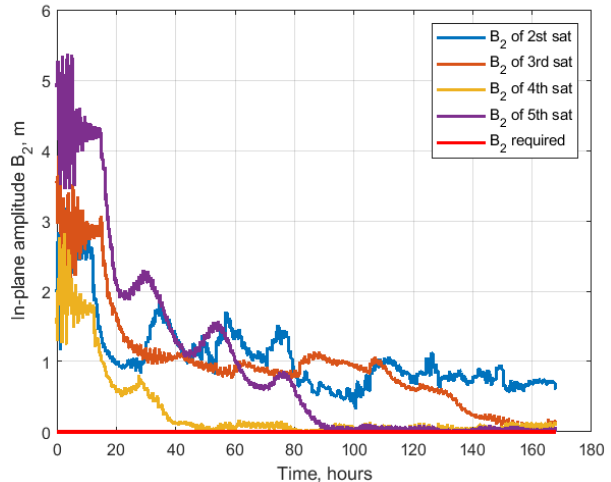
Figure 33. Relative shift.